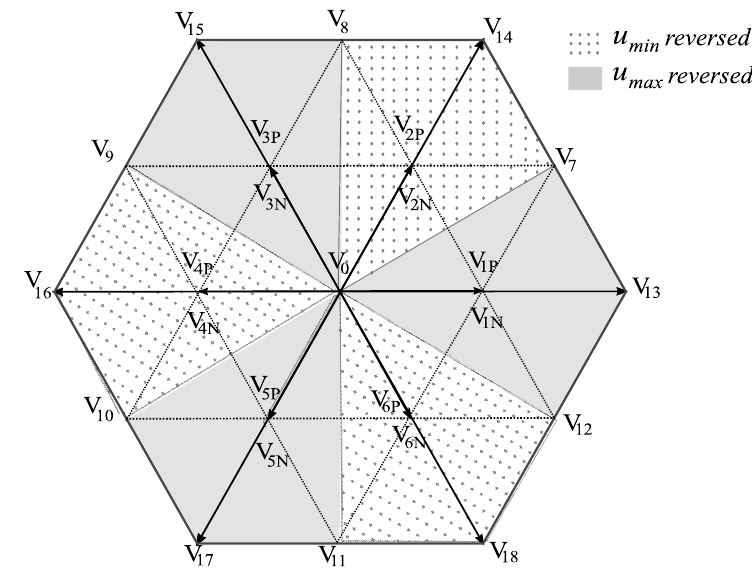
Figure 12. Space vector diagram of the proposed hybrid CBPWM with reduced